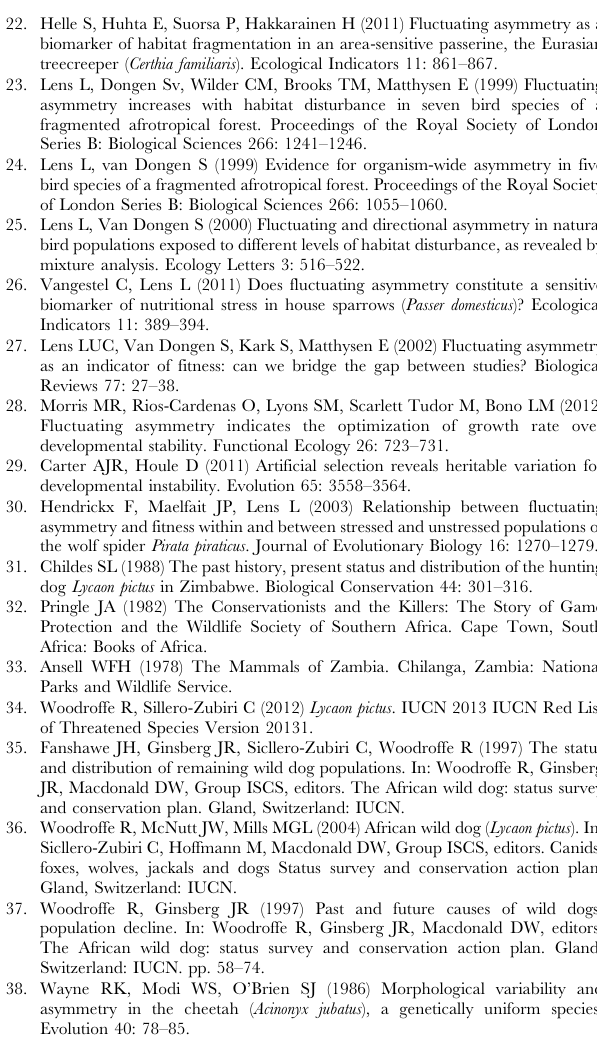
in Table S1. Based on these tests characters are labelled as either 1: included, or 0: not included. Table S3 Tests for ideal FA in calliper measurements of 2 (L 2 R)/(L + R) in Lycaon pictus skulls collected between 1913 and 2001. Character names refer to those given in Table S1. Based on these tests characters are labelled as either 1: included, or 0: not included. Table S4 Tests for ideal FA in photogrammetric measurements of 2 (L 2 R)/(L + R) in Lycaon pictus skulls collected between 1913 and 2001. Character names refer to those numbered 1 to 18 in Figure S1. Based on these tests characters are labelled as either 1: included, or 0: not included. Table S5 Analysis of variance table for fixed effects from mixed model linear regression fit to ln (|FA|) . p - values were obtained using a parametric bootstrap, as described in the main text. The interaction term refers to that between year and country and was retained despite not being significant.